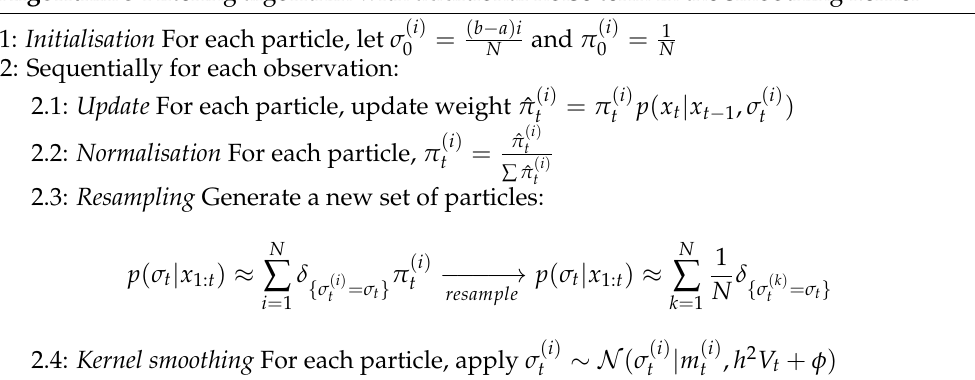
Algorithm 3 Filtering algorithm with additional noise term in the smoothing kernel